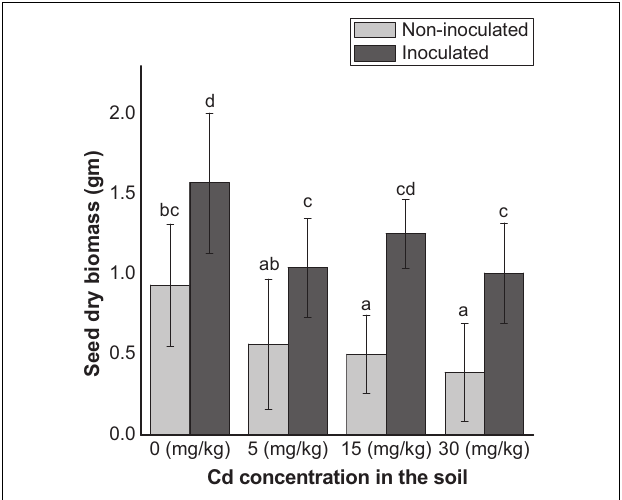
FIGURE 2 | Seed production affected by endophyte FZT214 under variable Cd stress. The different lowercase letters indicate significant variation between treatments ( p < 0.05) according to Duncan’s test of one-way ANOVA (mean ± STD, n = 6).